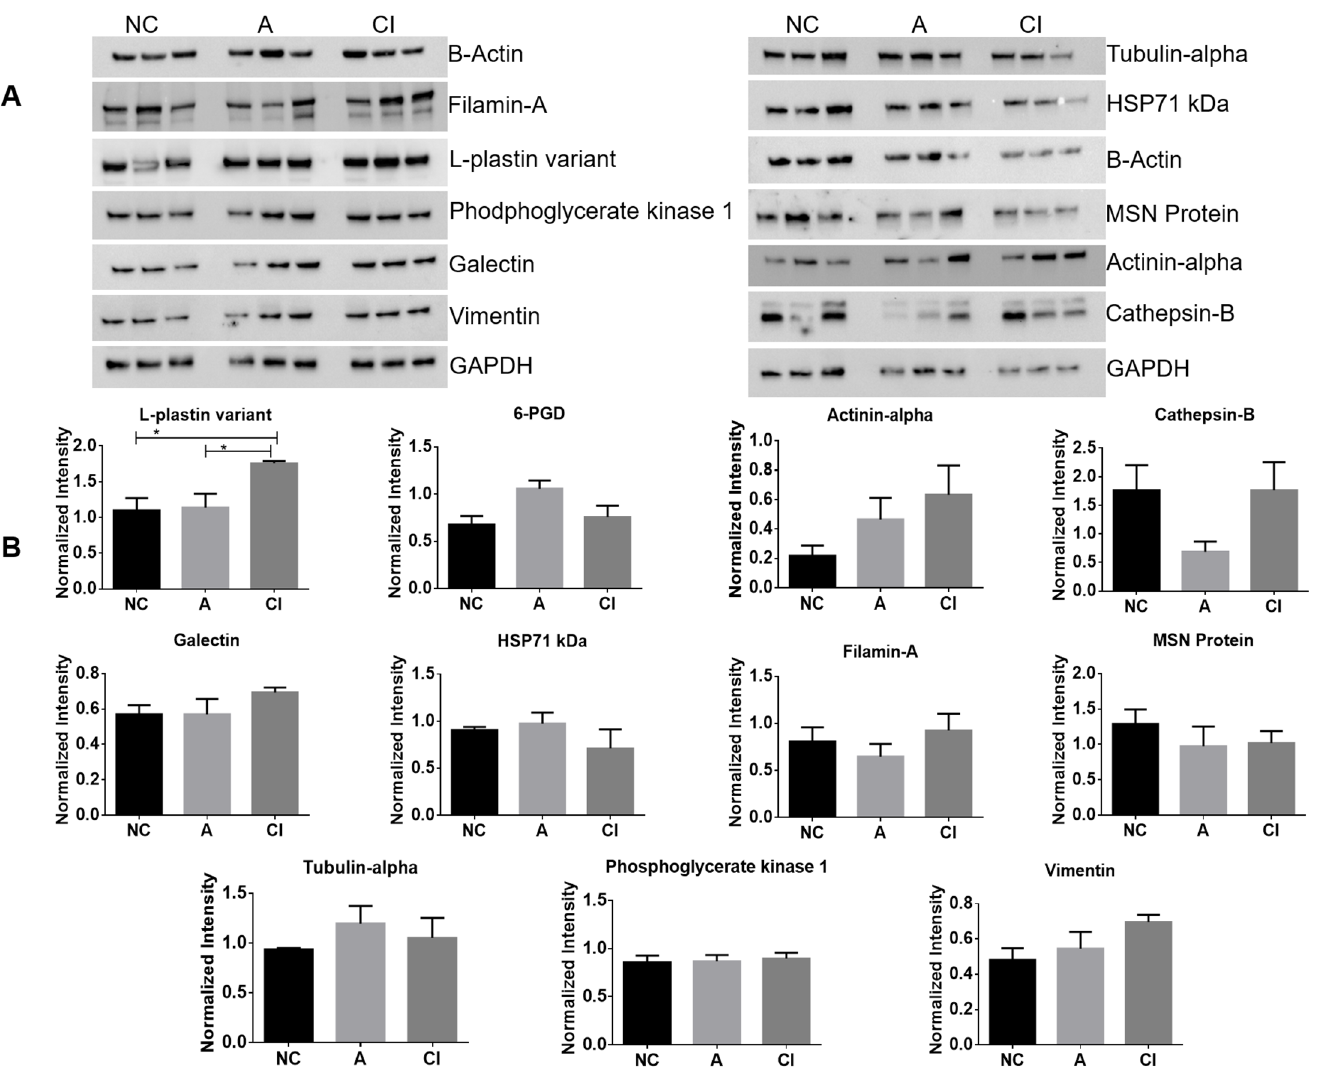
Fig 3. Validation of proteins identified by western blot. (A) Proteins identified by TMT labelingwere tested by western blot from MDM lysates of the same patients whose samples were used for proteomics. (B) Densitometry analysesfor the western blots were normalized againstGAPDH. The statistic analysisbetweenthe three groupsof patients was performed using One-way ANOVA with a significanceof * p < 0.05.For Plastin-L, there were significant differences betweenNC vs CI (p = 0.0316), and between ANI vs CI (p = 0.042).